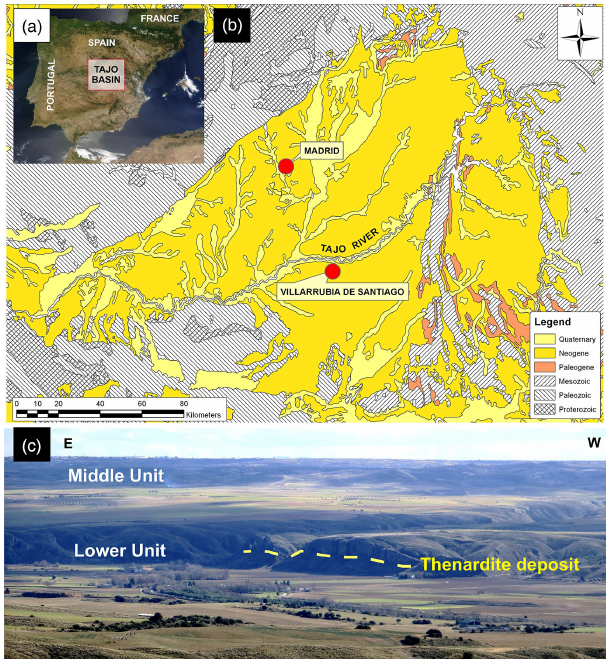
Figure 1. (a) Location of the Tajo basin in the central part of the Iberian Peninsula. (b) Simplified geological map of the Tajo basin and surrounding mountain belts (modified from the Spanish Geo- logical Map, scale 1 : 50000, IGME, 2013). The thenardite deposits appear near the village of Villarrubia de Santiago. (c) General view of the upper part of the Lower Unit and the base of the Middle Unit of the Miocene sequence of the Tajo basin in the Villarrubia de San- tiago area. The thenardite deposit is laterally continuous for tens of kilometers, although, due to the high solubility of the thenardite, it is not easily identified at all locations.